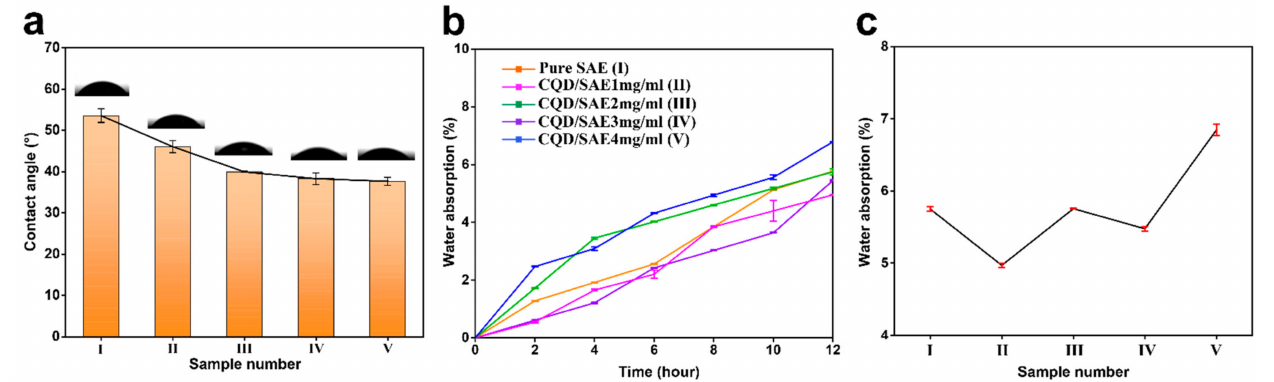
Figure 5. ( a ) Water angle of pure SAE and CQD/SAE coating films. ( b ) Water absorption of pure SAE and CQD/SAE coating films. ( c ) Final water absorption of the various